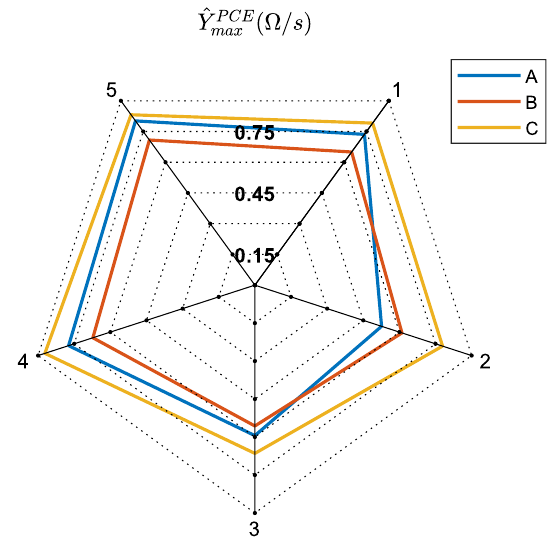
Fig.11: Maximal discrepancy 𝑌̂ 𝑚𝑎𝑥𝑃𝐶𝐸 for the fourth time step and each electrode configuration. Colours show source electrodes; blue: injection from A, red: injection from B, yellow: injection from C; numbers show the measurement